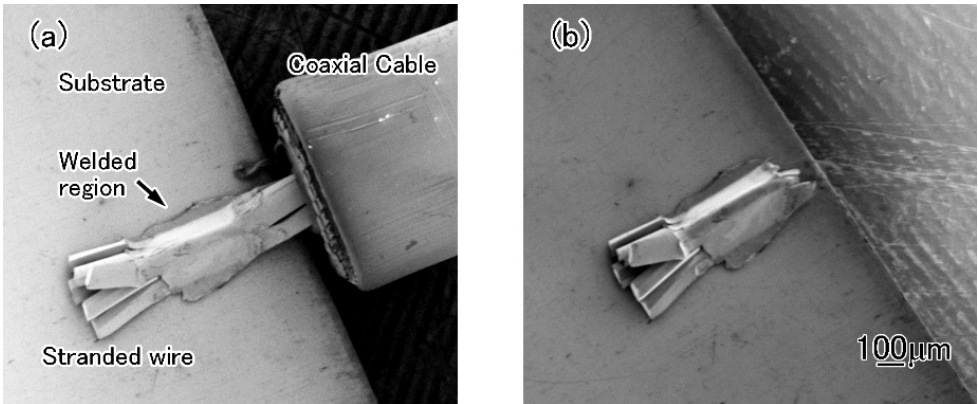
Figure 3. ( a ) Joint between the coaxial cable and the substrate. ( b ) Joint broken after tensile shear test.